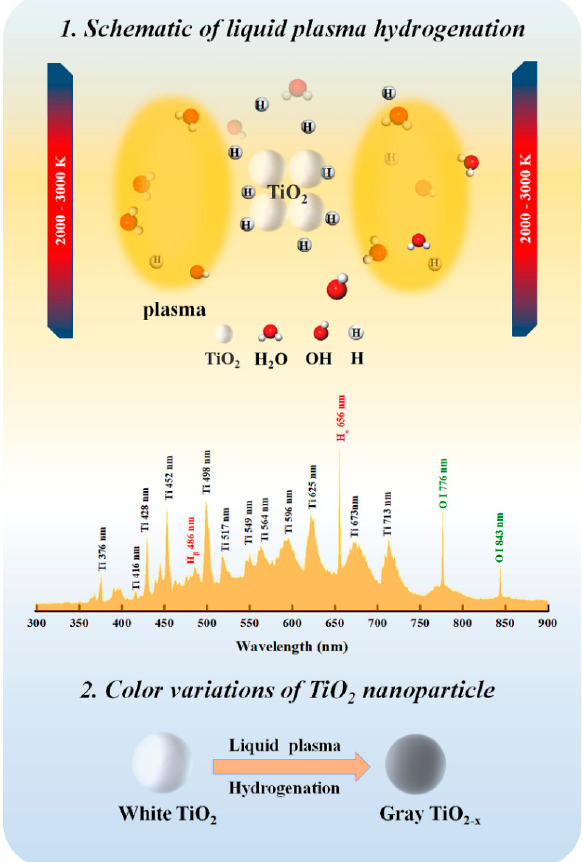
Figure 2. The synthesis mechanism of gray TiO 2 − x nanosphere assisted by liquid plasma and the corresponding optical emission spectrum originated from cathodic Ti electrodes.